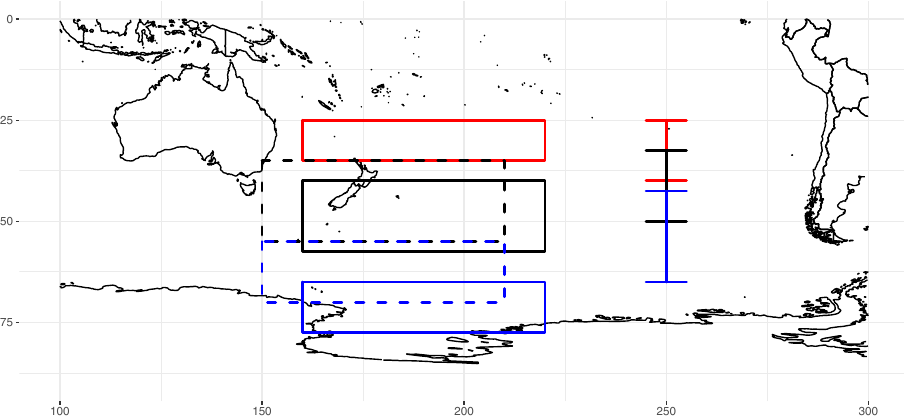
Figure 2. Area definitions of three earlier studies. Red lines show the STJ part, blue lines the PFJ part, and the black lines the gap between the two branches defined by the different studies. Continuous lines refer to the split-flow index (SFI) of Bals-Elsholz et al. (2001), and dashed lines mark the two regions defined in Yang and Chang (2006). The right side shows the meridional boundaries used in the split index defined by Inatsu and Hoskins (2006). Table 1. List of split-jet definition constraints as suggested in three earlier studies. The indices resemble specific areas depicting the equator- ward branch of the split (STJ), the gap between the jets (GAP), and the polar front jet (PFJ) part. SFI (BE) STJ (YC) STJ (IH) PSI Yang and Chang (2006) Inatsu and Hoskins (2006) Defined within this study (Sect.